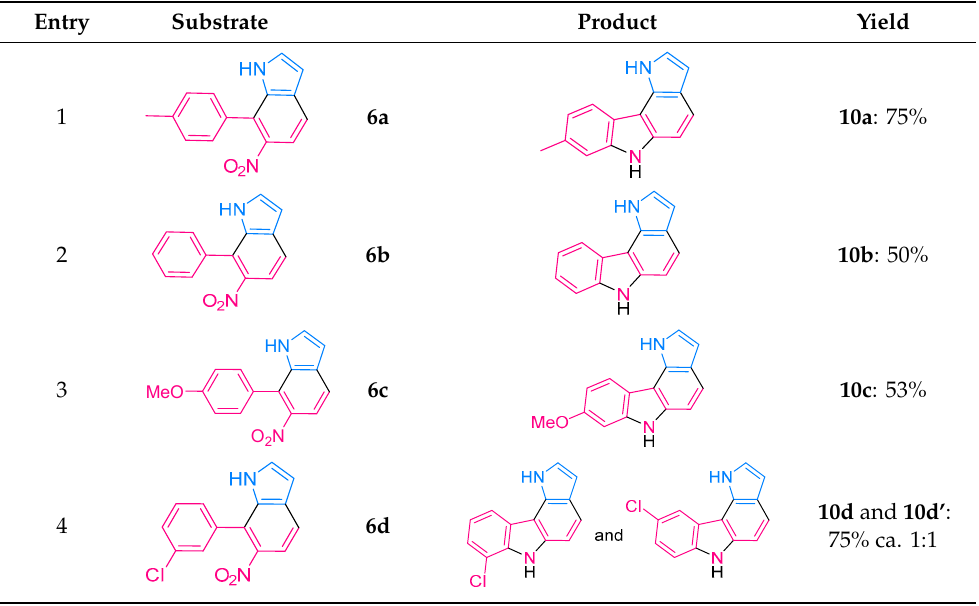
Table 3. Results obtained in the Cadogan reaction (triethyl phosphite at reflux, 5 h, under Ar) applied to 7-aryl-6-nitroindoles 6 1 .